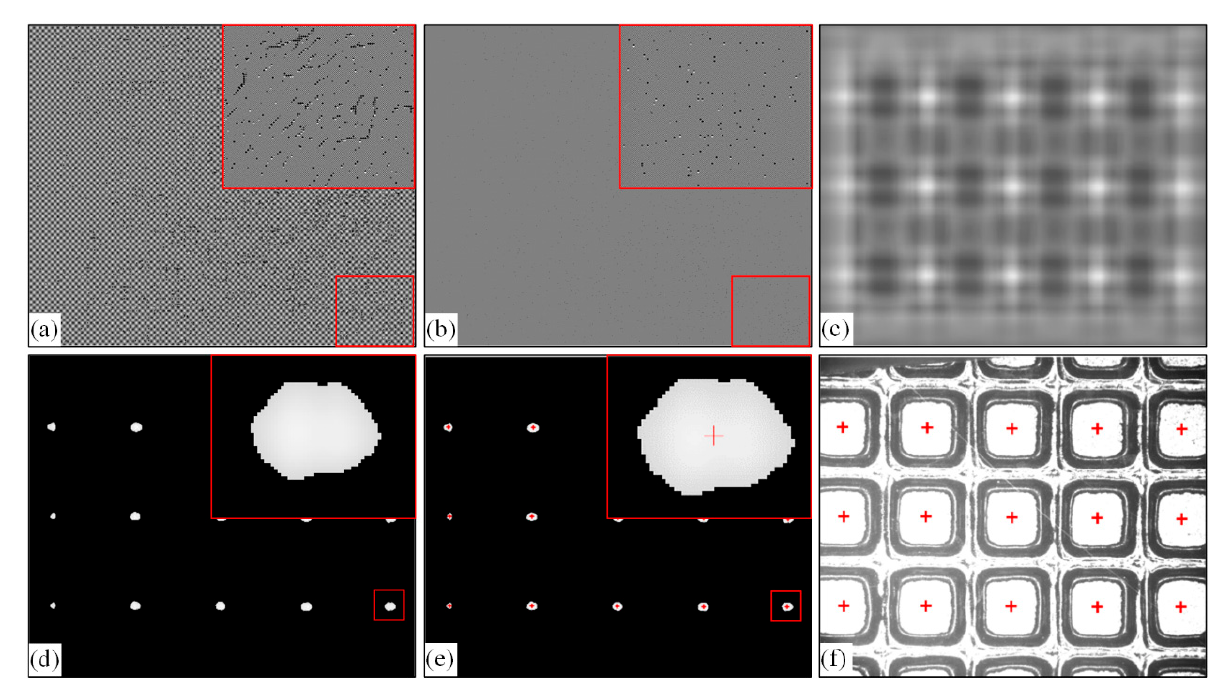
Figure 7. Detection results of the chip region for each step. ( a ) The result of the parameterized tem- plate; ( b ) the result of the parameterized wafer image; ( c ) correlation result; ( d ) the result of thresh- olding; ( e ) the result of extremum search; ( f ) the center of gravity position of the chip